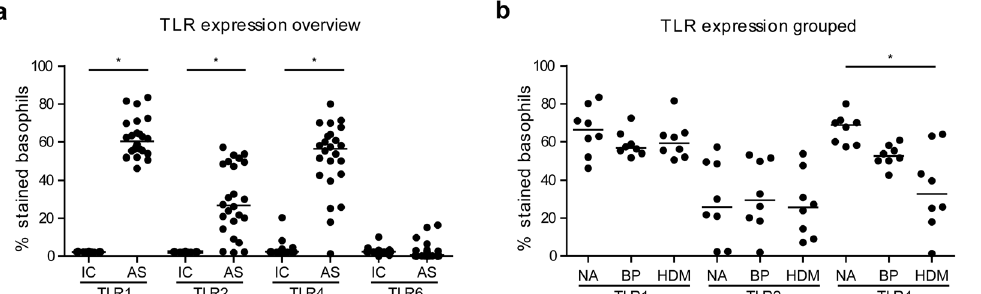
Fig 3. Overview of TLR expression on purified human basophils. Expression levels of significantly detectable TLR1, 2, and 4 were investigated between non-allergic (NA), birch pollen (BP)-allergic and house dust mite (HDM)-allergic donors (n = 8, each): ( a ), group-wise (n = 24 each) comparisons of TLR expressions (antibody staining, AS) with the respective isotype controls (IC); ( b ), comparison of TLR1, 2, 4 expression between non-allergic (NA) donors and HDM-/PB-allergic patients (n = 8, each). Group comparisons were performed by Wilcoxon matched pairs test in (a) and Kruskal-Wallis test with Dunn ’ s post hoc test in (b). Bars represent medians. NS, non-stimulated; * , p < 0.05.